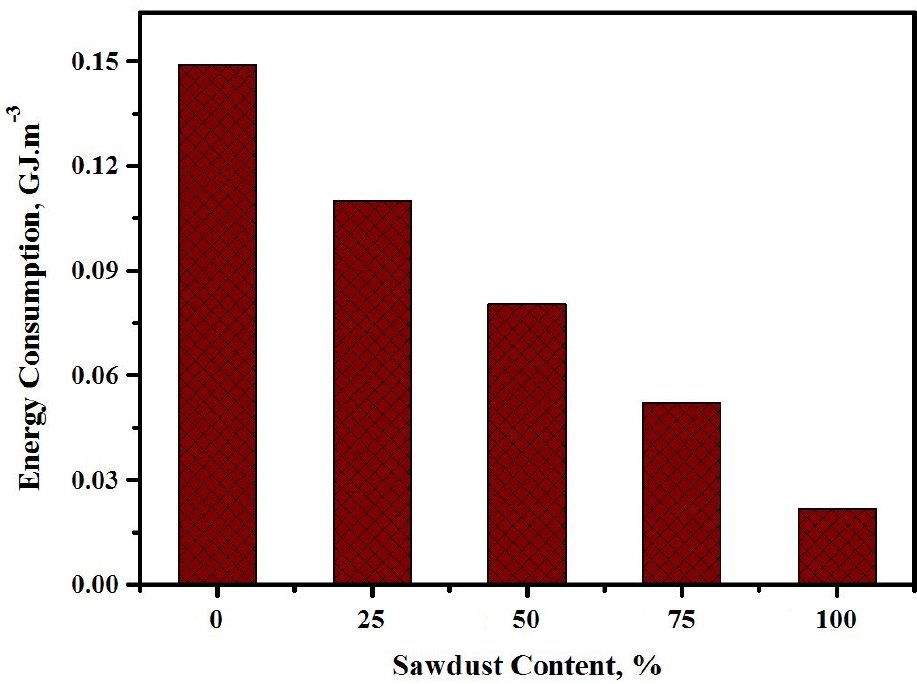
Figure 24. Energy consumption of the concretes prepared at various sawdust contents.